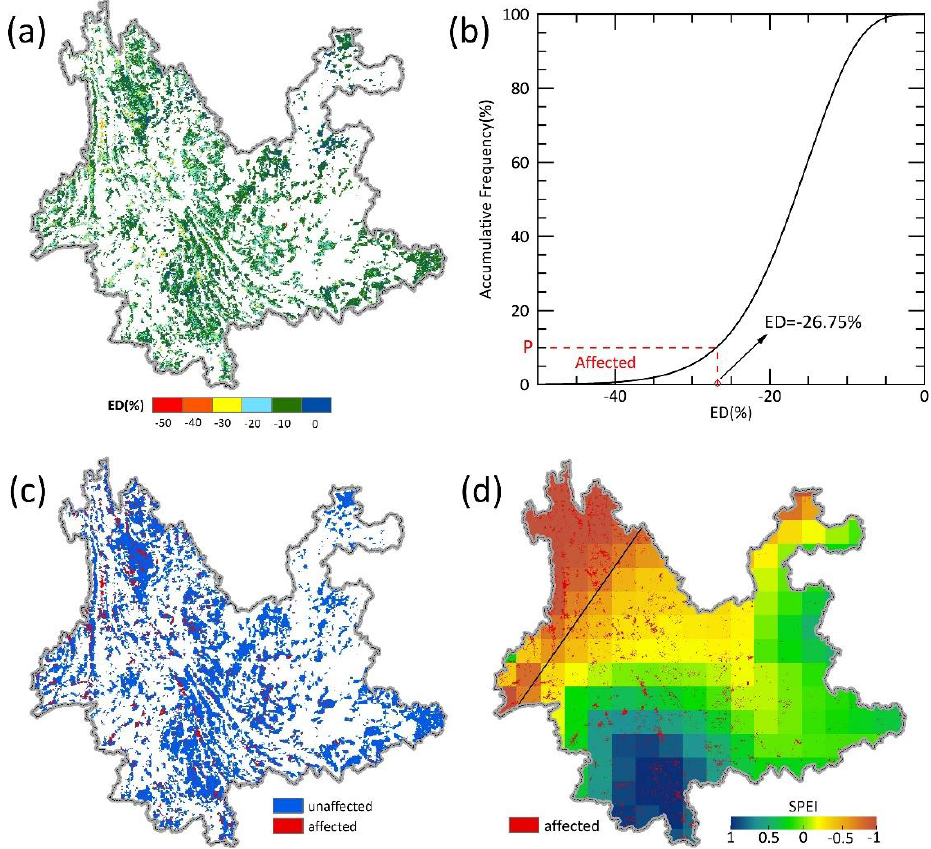
Figure 3. The determination of forest recovery area: ( a ) Average ED (EVI Deficit (%); EVI: enhanced vegetation index) of forested areas during the drought event of 2009–2012 in Yunnan Province. ( b ) The top 10% area with the most negative ED (<−26.75%) was selected as the drought-affected area for this study. ( c ) Forested area in Yunnan was further divided into two regions: affected (ED < −26.75%, red) vs. unaffected (ED ≥ −26.75%, blue). ( d ) Standardized precipitation evapotranspiration index (SPEI) of Yunnan Province in 2014. Forest areas affected by the prolonged drought during 2009–2013 (ED < −26.75%, red spots in ( c , d )) with water condition improved in 2014 (SPEI > −0.5, red spots below the black line in ( d )) were defined as the potential recovery area of the forest. The white regions in ( a , b ) represent nonforest land.